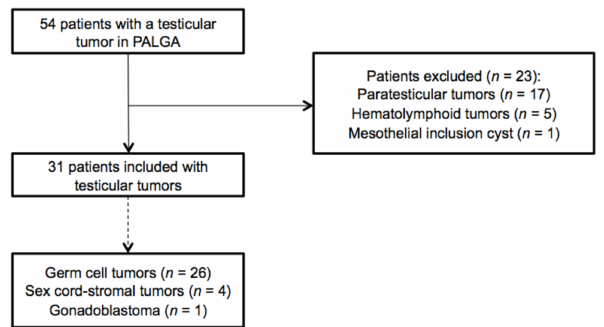
Figure 2. Flowchart of included and excluded patients during the search